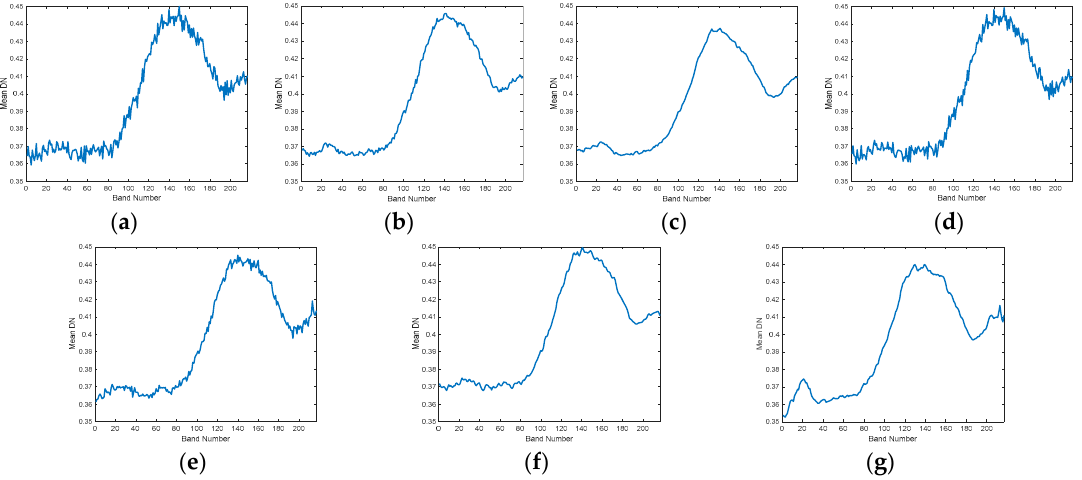
Figure 11. Vertical mean profiles of the denoising results of the second spectral band in the Airborne Visible/Infrared Imaging Spectrometer (AVIRIS) Salinas image: ( a ) original band, ( b ) HyRes, ( c ) LRTV, ( d ) LRMR, ( e ) NAILRMA, ( f ) LRTDTV, and ( g ) proposed.